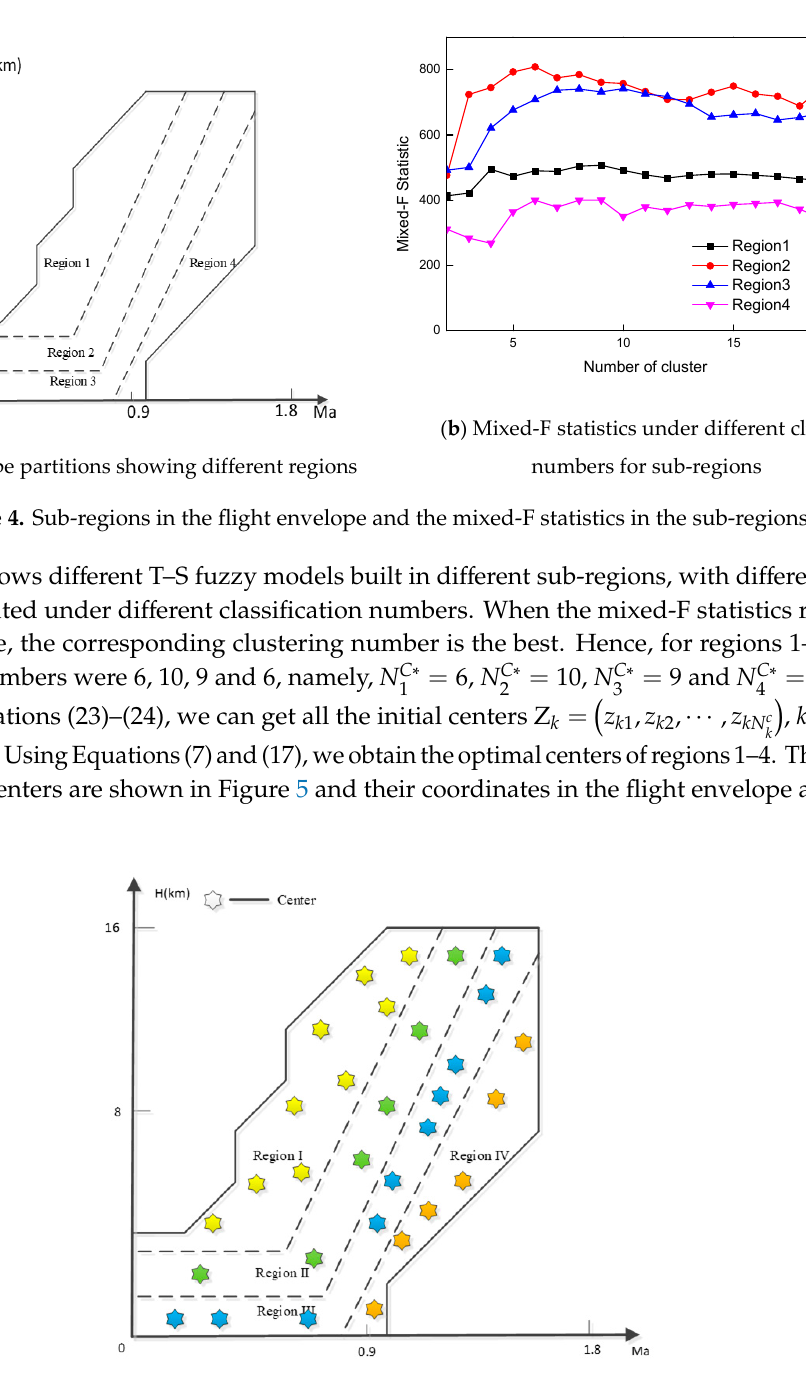
Figure 5. Cluster centers of sub-regions. Table 1. Cluster centers of the flight envelope.